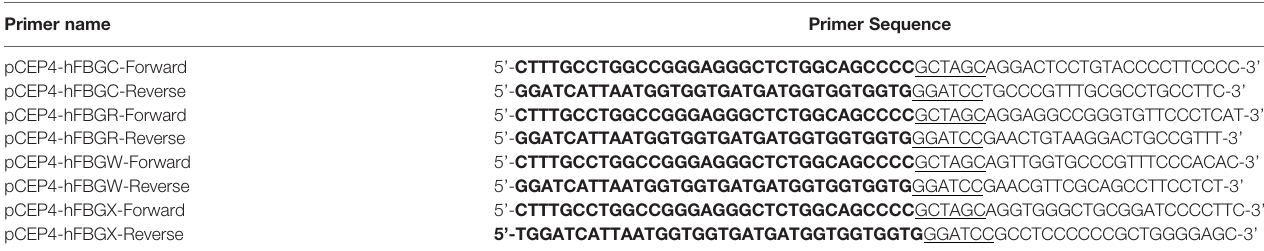
TABLE 1 | Oligonucleotide primers used for the cloning of the FBG-like domains in the pCEP4-BM40-8HIS/Puromycin vector using the SLIC